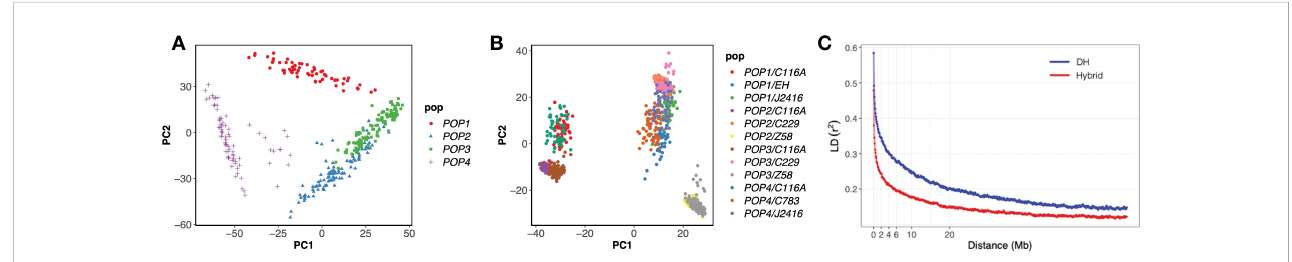
FIGURE 2 Analysis of genetic structure in the DH and hybrid panels. (A) the principal component analysis for the DH panel. (B) the principal component analysis for the hybrid panel. (C) Linkage disequilibrium decay in the two